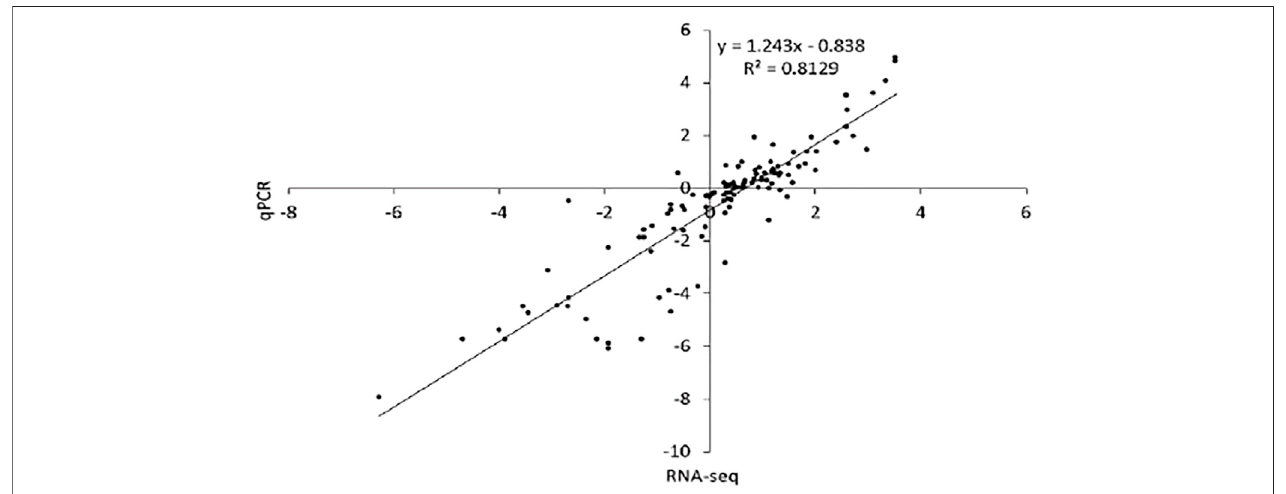
FIGURE 8 | Validation of expression results using qRT-PCR represents the correlation between qRT-PCR and RNA-seq expression results for randomly selected DEGs related to fi ve dormancy stages considered under